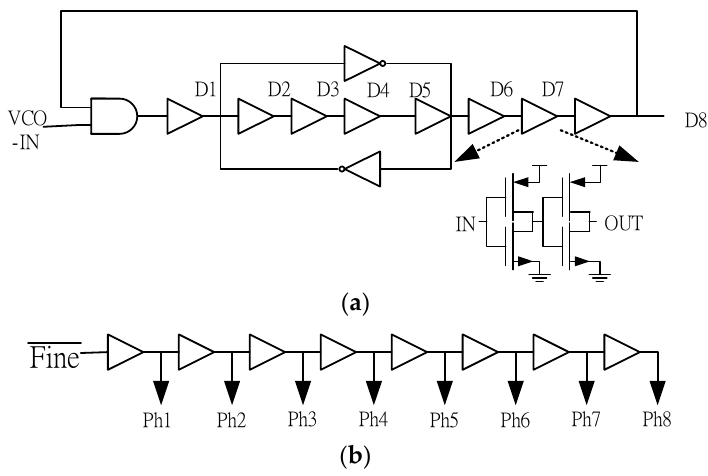
Figure 8. ( a ) Delay line oscillator circuit and ( b ) delay line circuit.